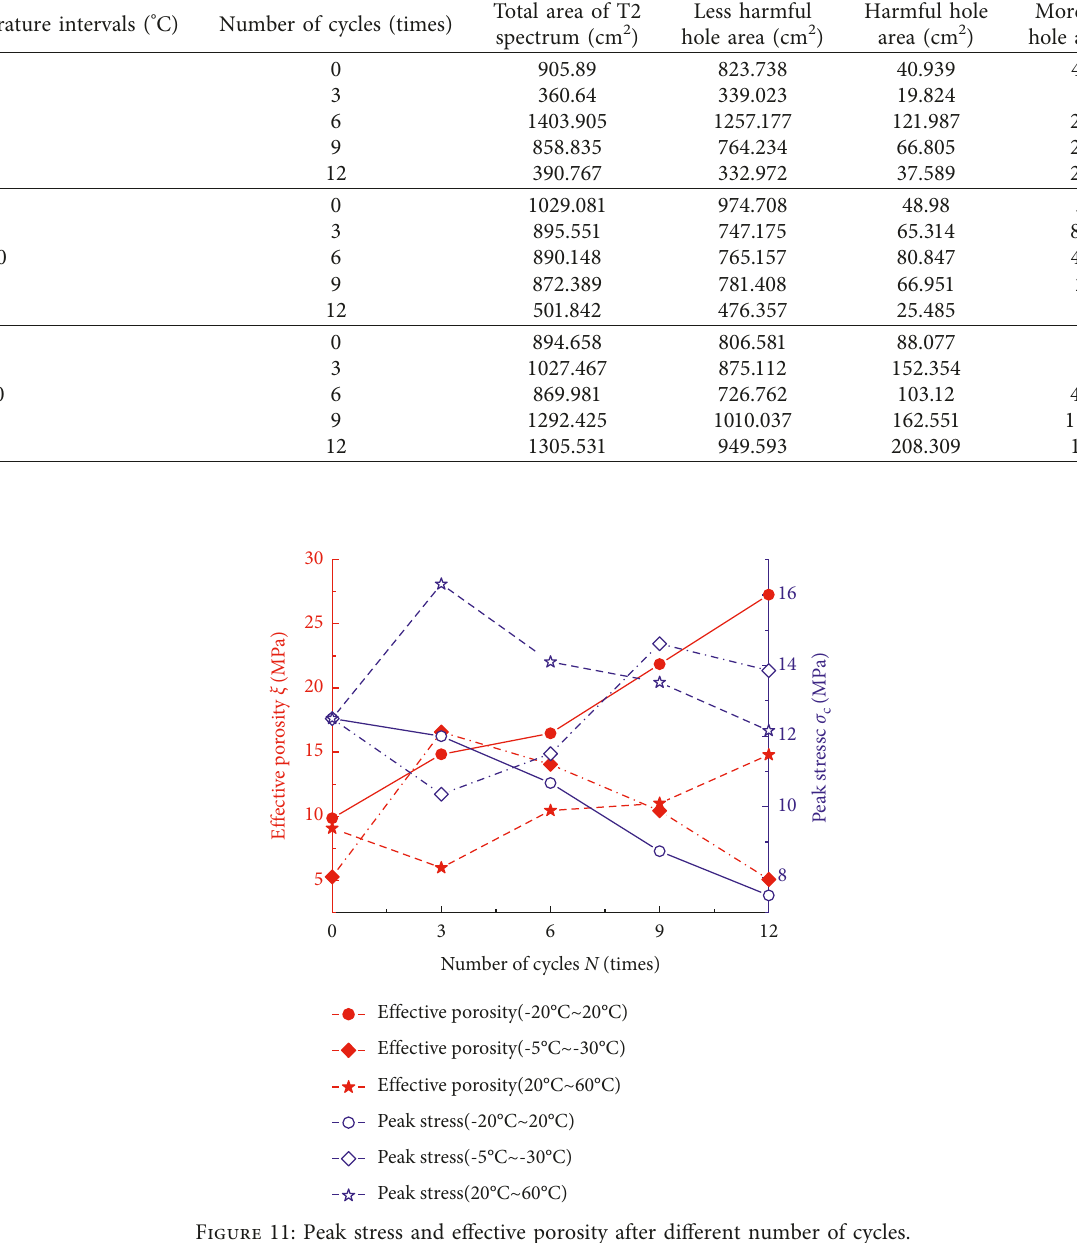
Table 11: NMR spectral area of semirigid base after different number of cycles at different temperature intervals. Temperature intervals ( ° C)